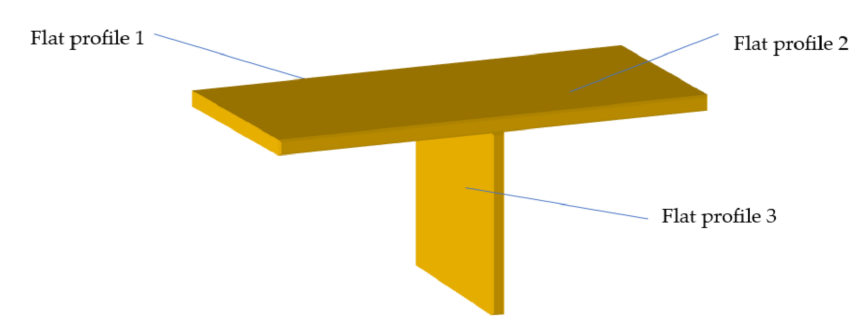
Figure 6. Baseline structural element.